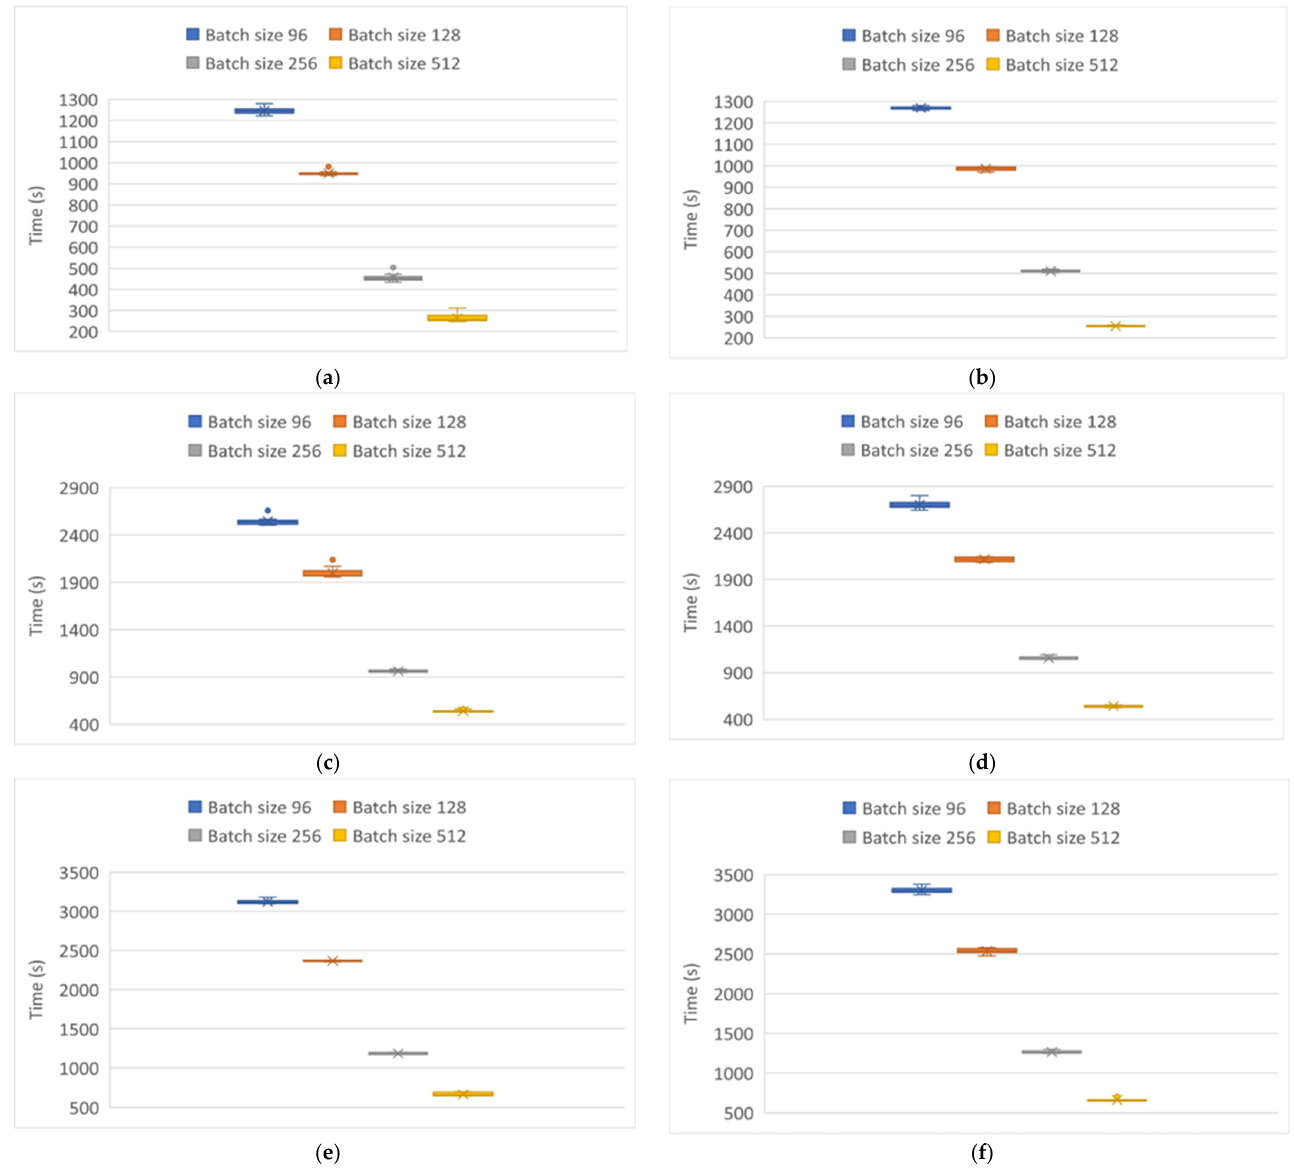
Figure 13. Processing time variability in modeling particle behavior PM 10 . ( a ) Elman neural network using Adam optimizer. ( b ) Elman neural network using Adamax optimizer. ( c ) GRU neural network using Adam optimizer. ( d ) GRU neural network using Adamax optimizer. ( e ) LSTM neural network using Adam optimizer. ( f ) LSTM neural network using Adamax optimizer.